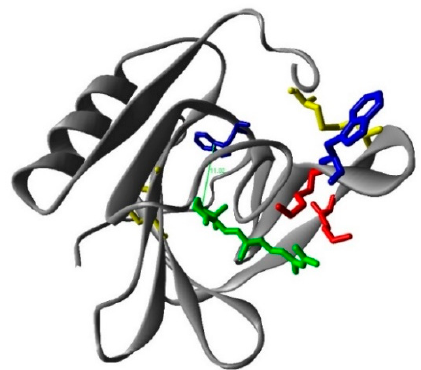
Figure 5. The calculated structure of the β -lactoglobulin (monomer)–retinoic acid complex. Red: lysines; blue: tryoptohan 19 (back) and 61 (front); yellow: cysteines; green: retinoic acid.